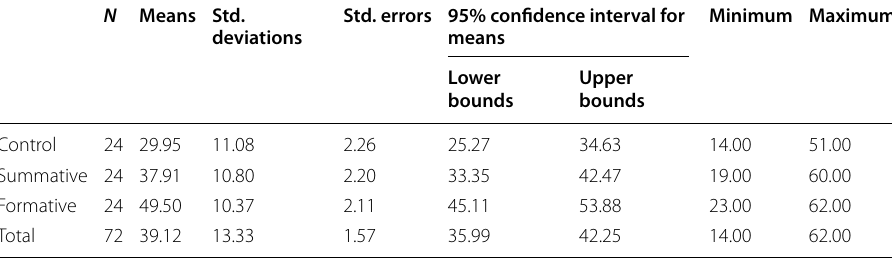
Table 4 Inferential statistics of all groups on the test anxiety post-tests Sum of squares Df Mean squares F Sig. Between groups